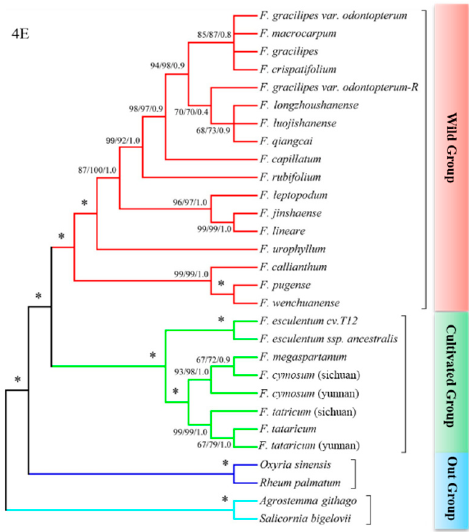
Figure 4. Phylogenetic analysis of genus Fagopyrum based on multiple combinations of DNA barcodes. The figure ( A – E ) represent ndhA intron + psbE-psbL, rbcL-accD + psbE-psbL, matK + ndhA intron, matK + psbE-psbL, and matK + psbE-psbL+ ndhA intron, respectively. The * symbols in the phylogenetic tree show that the support rate of this branch is 100/100/1.0.